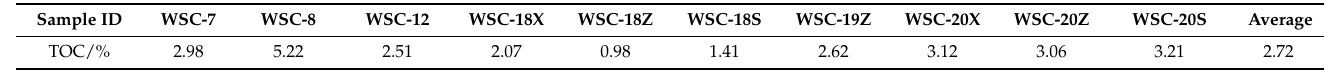
Table 3. Test results of total organic carbon content of lower Cambrian black shale in Wenshuicun, Guizhou. Sample ID